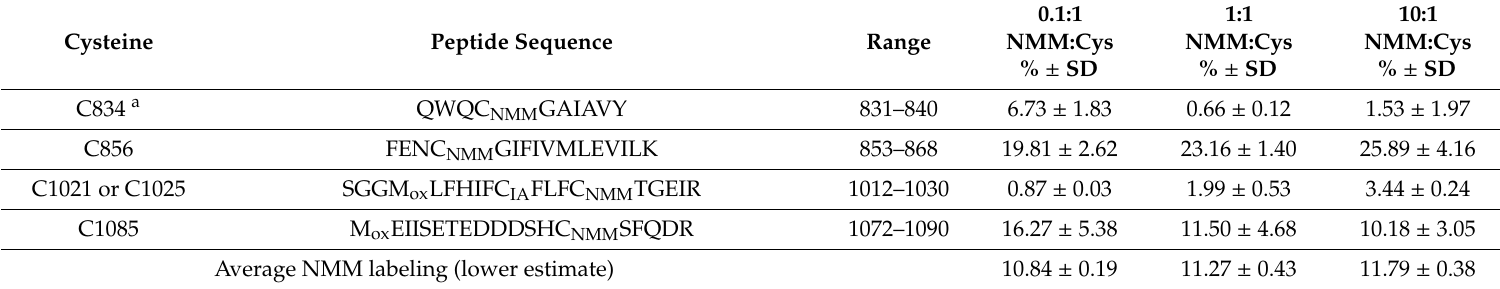
Table 2. The percentage of N -methylmaleimide (NMM) labeling for each cysteine in the ∆ 1-688 human TRPA1 was analyzed from tryptic digested peptides. The NMM labeling was calculated for each cysteine by area of NMM modified peptide divided with total areas of NMM modified peptide and equivalent iodoacetamide (IA) modified peptide. The mass spectrometry experiments were performed in triplicates for each concentration, and the quantified data presented in the mean value with standard deviation (SD). The proteins were incubated at di ff erent concentrations of NMM, corresponding to di ff erent molar ratios relative the total number of cysteines.